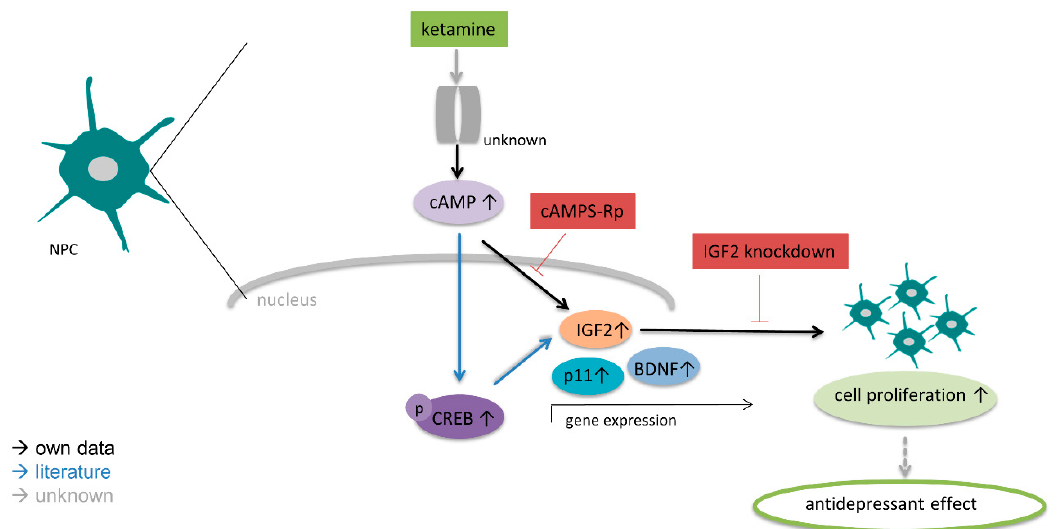
Figure 9. Hypothesis of the molecular mechanism of action in human NPCs induced by ketamine. Ketamine treatment increases IGF2 expression via cyclic adenosine monophosphate (cAMP) signaling leading to enhanced NPC proliferation.